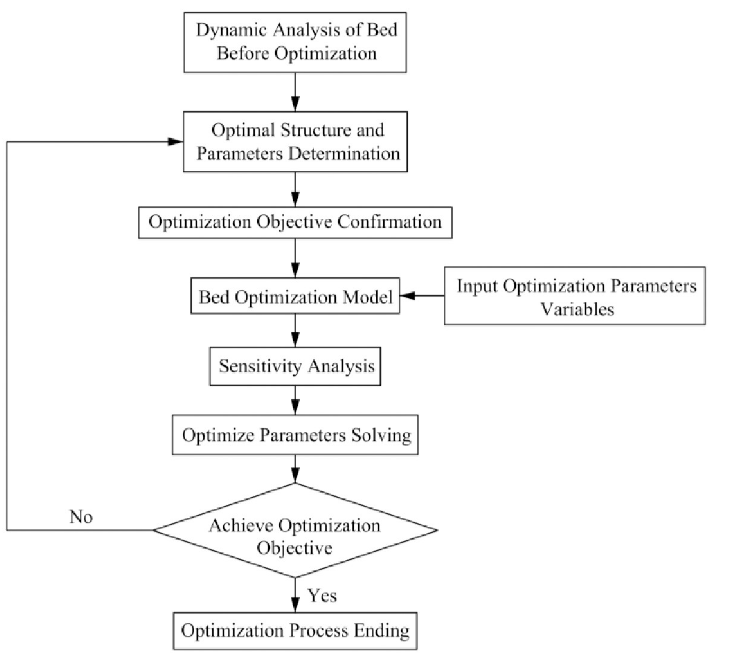
Fig 10. Flow chart of bed structure